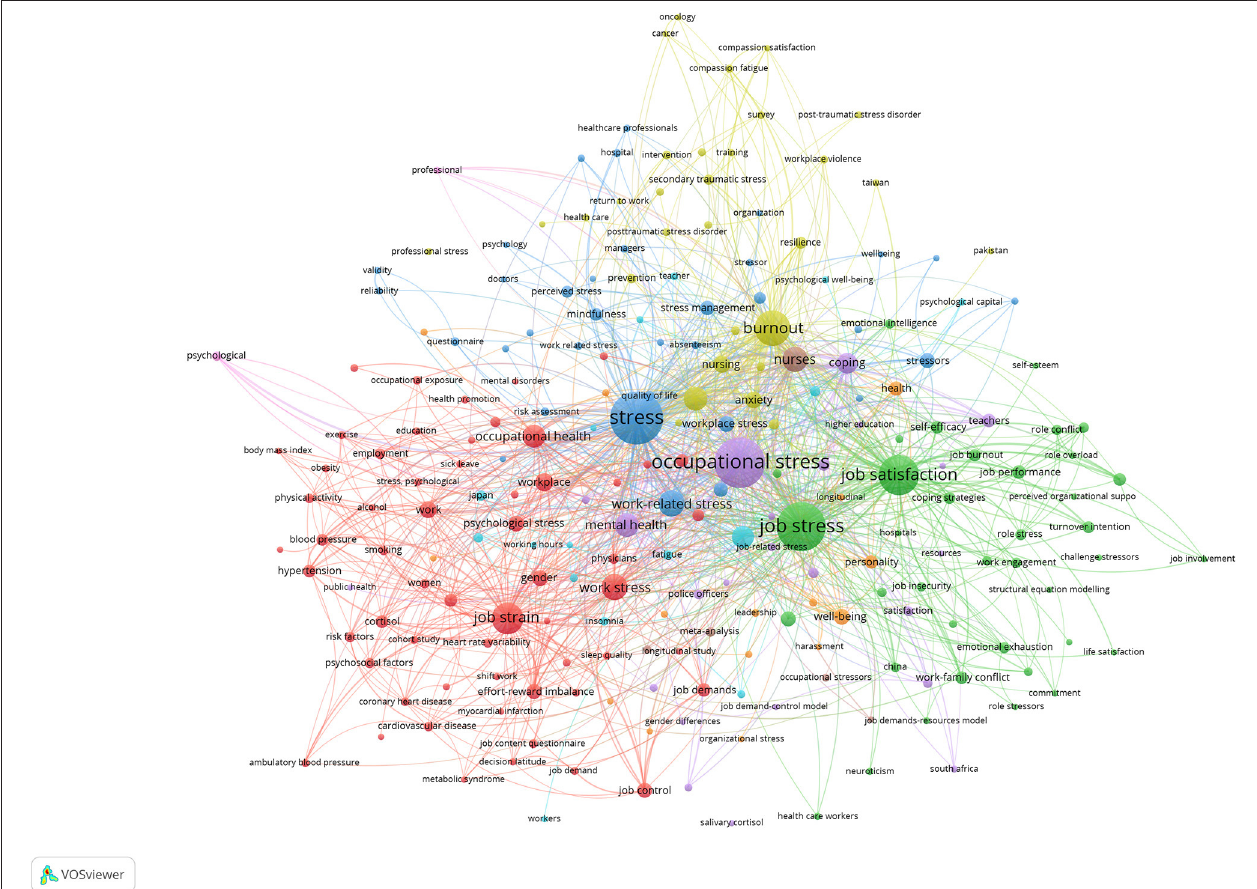
FIGURE 3 | Bibliometric analysis of co-occurrence of keywords in publications of occupational stress. The size of nodes indicates the frequency of occurrence. The curves between the nodes represents their co-occurrence in the same publication. The shorter the distance between two nodes, the larger the number of co-occurrence of the two